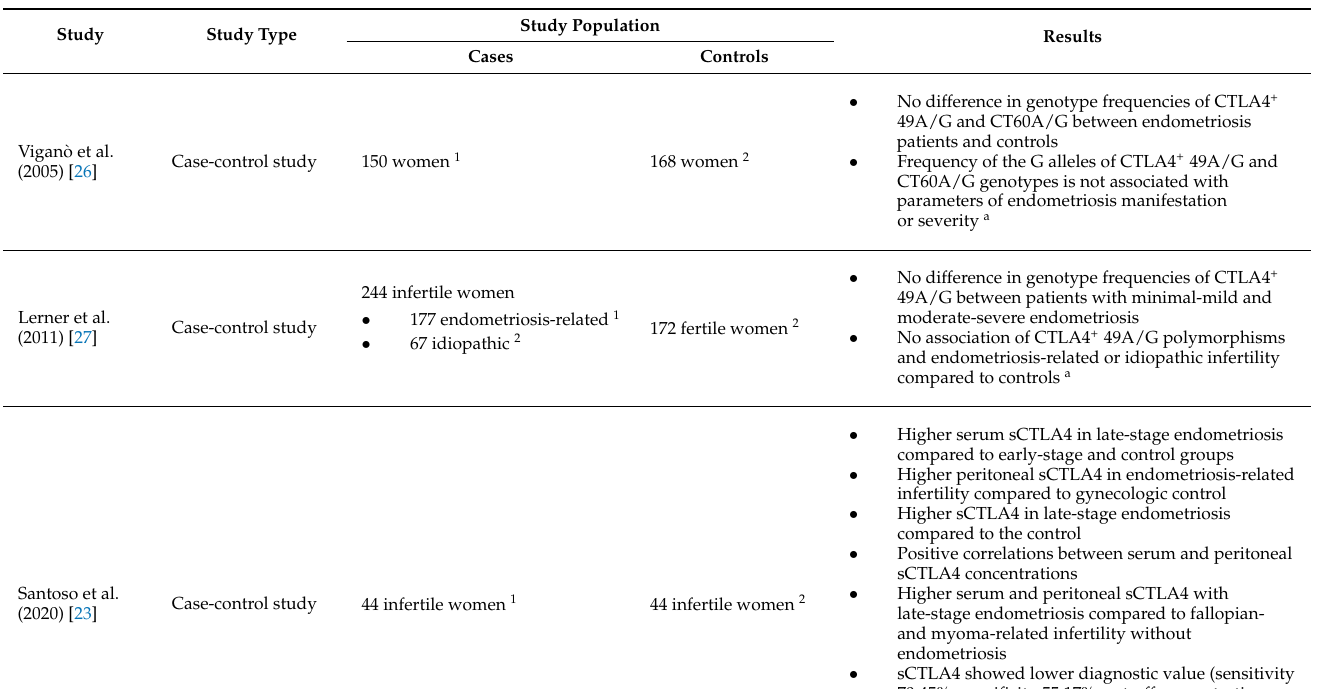
Table 1. Characteristics of the included